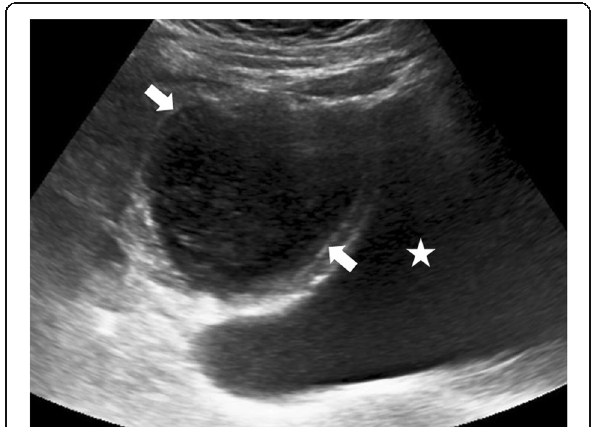
Fig. 37 A 6-year-old female patient presenting to ED with suprapubic pain. Sagittal view US image shows a round-shaped cystic lesion (arrows) above the superior surface of the bladder (star). Due to the mixed echogenicity of the lesion, it was considered an infected urachal cyst. Surgical findings confirmed the